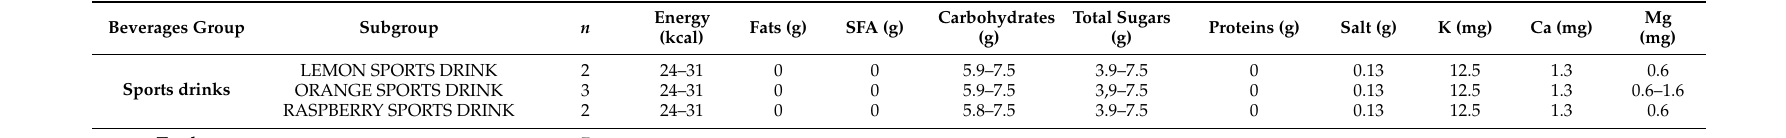
Table 4. Nutrition facts from the “sports drinks” group in the Spanish food market.